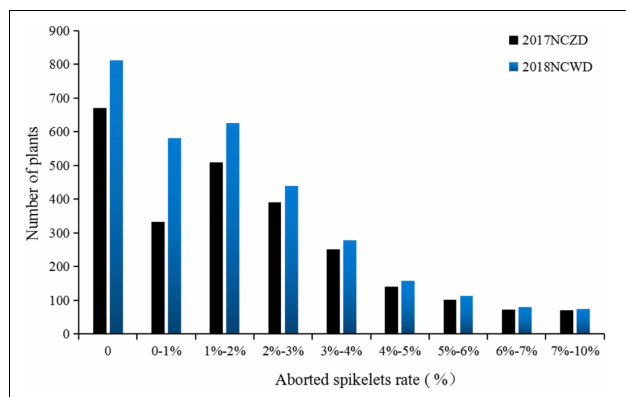
FIGURE 3 | The severity of panicle apical abortion (PAA) distribution of F 2 plants from the cross of CSSL176 × CH121. 2017NCZD and 2018 NCWD represent the middle-season rice in Nanchang, Jiangxi in 2017 and the late-season rice in Nanchang, Jiangxi in 2018,